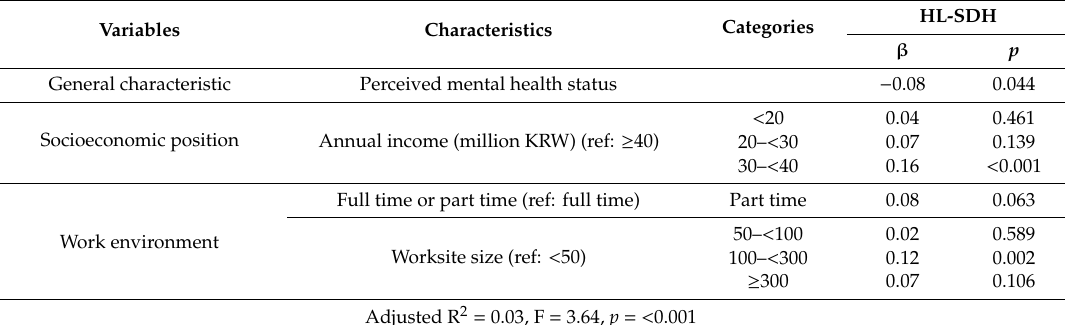
Table 4. Multiple regression for factors predicting HL-SDH ( N =